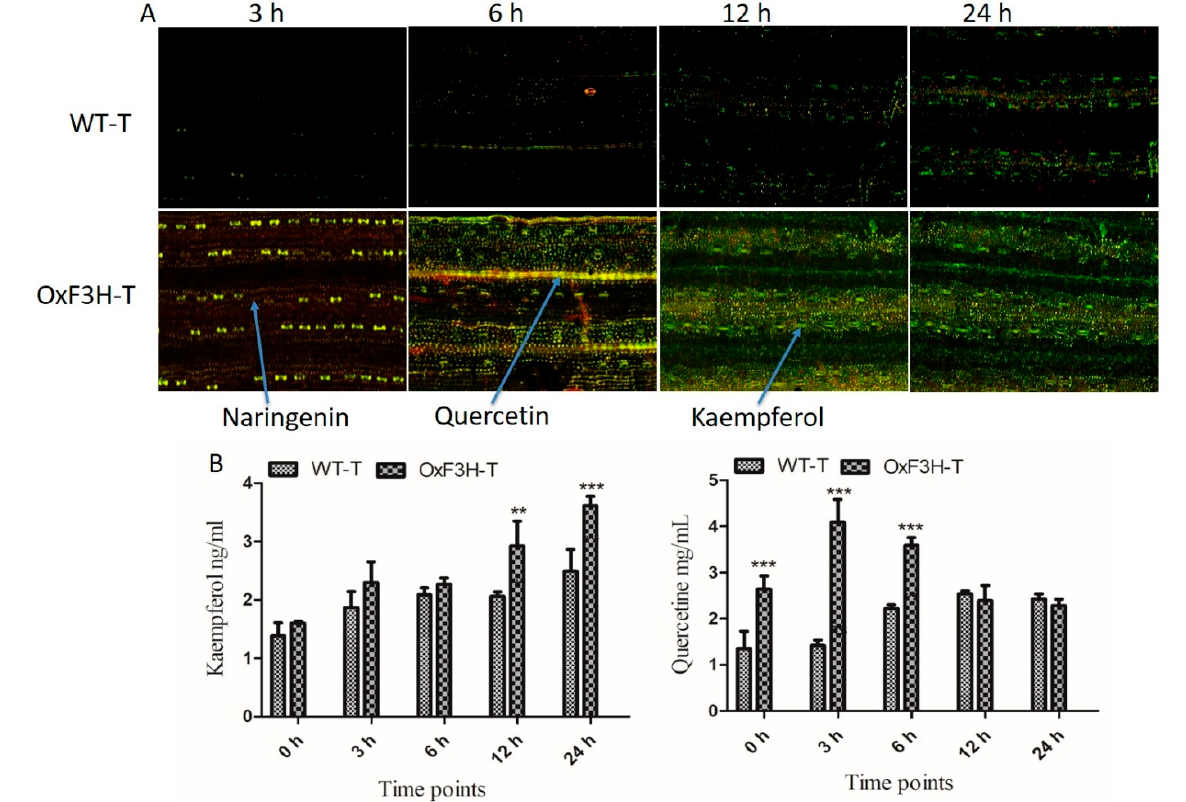
Figure 4. Detection and quantification of flavonoids in OxF3H and WT in response to BLB stress. Naringenin, kaempferol, and quercetin were visualized in plant tissue via DAPB staining using a confocal laser scanning microscope (CLSM). ( A ) Flavonoids weredetected in both the OxF3H and WT plants tissues, while arrows indicate different colors, where red shows naringenin, orange shows quercetin, and green shows kaempferol. Samples for in situ detection of flavonoids were collected after 3, 6, 12, and 24 h post-inoculation of Xanthomonas oryzae pv. oryzae. ( B ) Quantitative accumulation of flavonoids; the right graph shows quercetin while the left graph shows kaempferol accumulation in response to BLB stress at various timepoints. Graph bars indicate mean ± standard deviation and ** shows p ≤ 0.01 and *** shows p ≤ 0.001 significant difference, as analyzed using two-way ANOVA and a Bonferroni